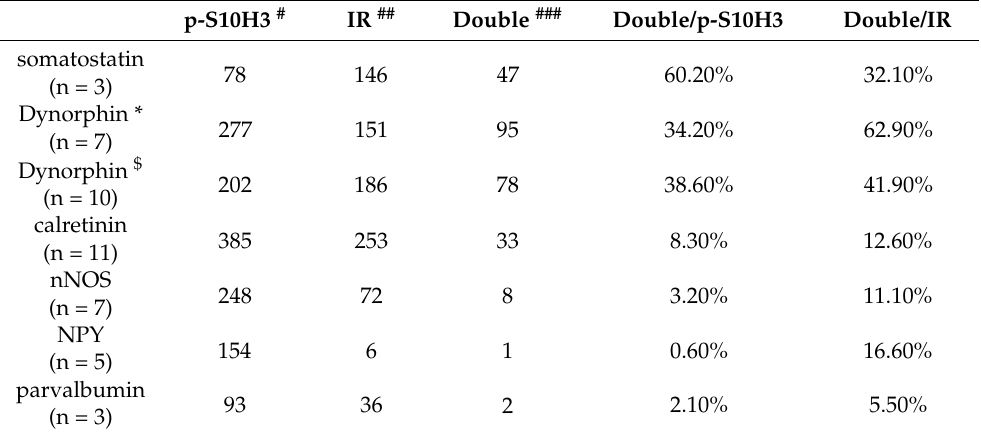
Table 3. Proportion of p-S10H3 nuclei after burn injury in different subsets of neurons defined by their neurochemical phenotypes in laminae I and IIo. nNOS: neuronal nitrogen monoxide synthase. p-S10H3 # IR ## Double ###